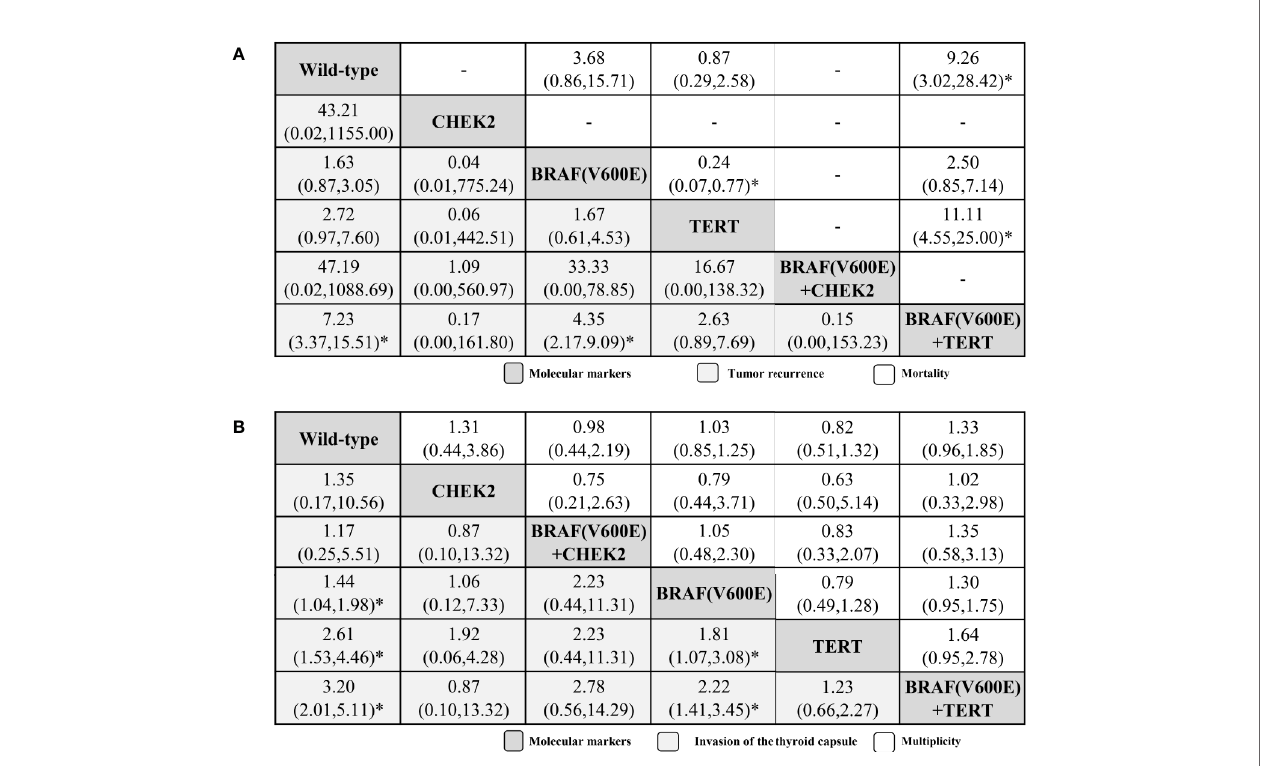
FIGURE 4 | Histopathological feature pro fi les for the tumor recurrence and mortality (A) , invasion of the thyroid capsule and multiplicity (B) based PTC outcomes. From left to right, molecular markers for tumor recurrence and mortality (A) , invasion of the thyroid capsule and multiplicity (B) are ranked by mean rank and SUCRA score. Information relating to the ORs and 95% CrI is listed in the column, with the rows displaying molecular marker identity. OR values higher than 1 favor the column-de fi ning treatment (i.e., the left-most in order), indicating histopathological features associated with a worse prognosis. To obtain ORs for comparisons in the opposite direction, reciprocals should be taken. *Signi fi cant